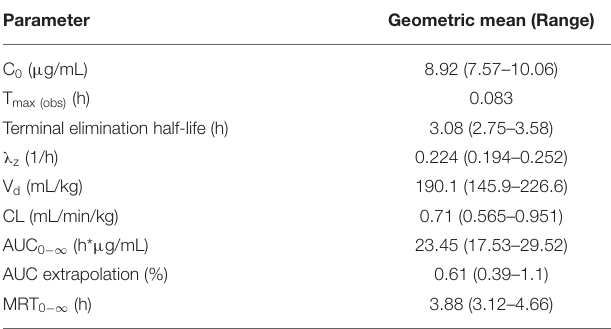
TABLE 2 | Pharmacokinetic parameters estimated from meloxicam concentrations in plasma samples collected from live birds (pre-slaughter) following a single 1 mg/kg IV dose administered to laying hens ( n =